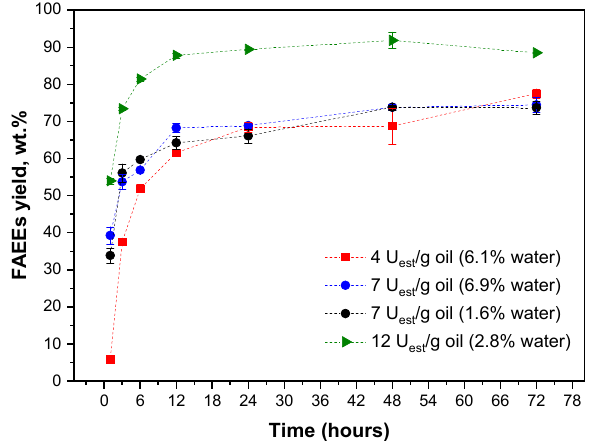
Figure 8. Profiles of FAEE yield vs. time for the transesterification of soybean oil (15 g) with ethanol (oil/ethanol molar ratio of 1:6) catalyzed by Eversa-mCLEA-CLEA at 40 °C and 1700–2000 rpm stirring in a vortex flow reactor.